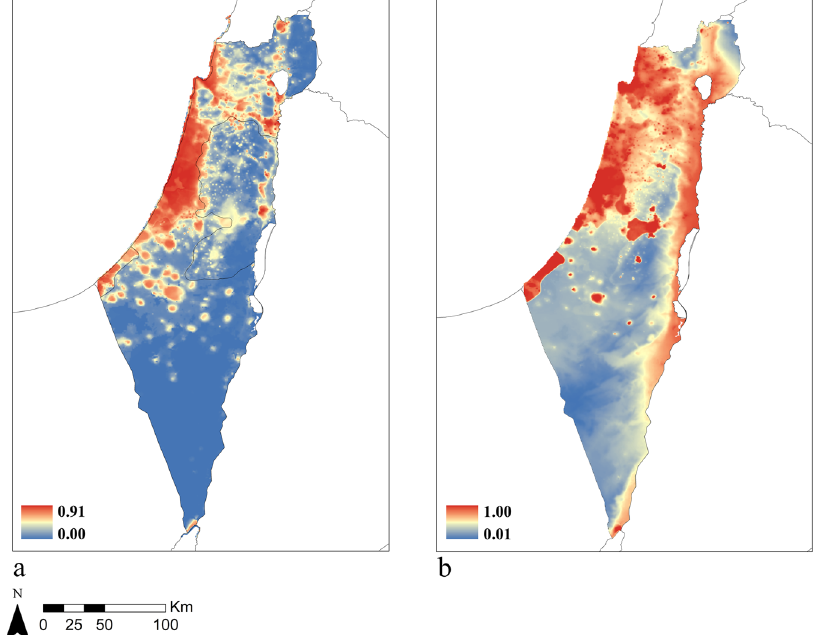
Figure 3. A continuous map of average probabilities for suitable areas for current and potential common myna presence based on the MaxEnt model ( a ) and the JSDM ( b ). Legend contains colour code representation of